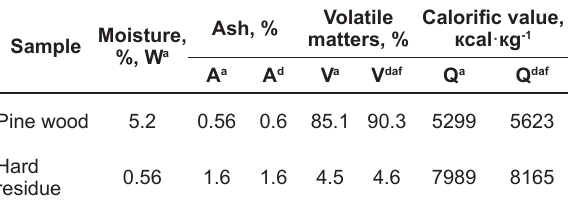
Table 1. The results of proximate analysis of pine wood and its pyrolysed hard residue